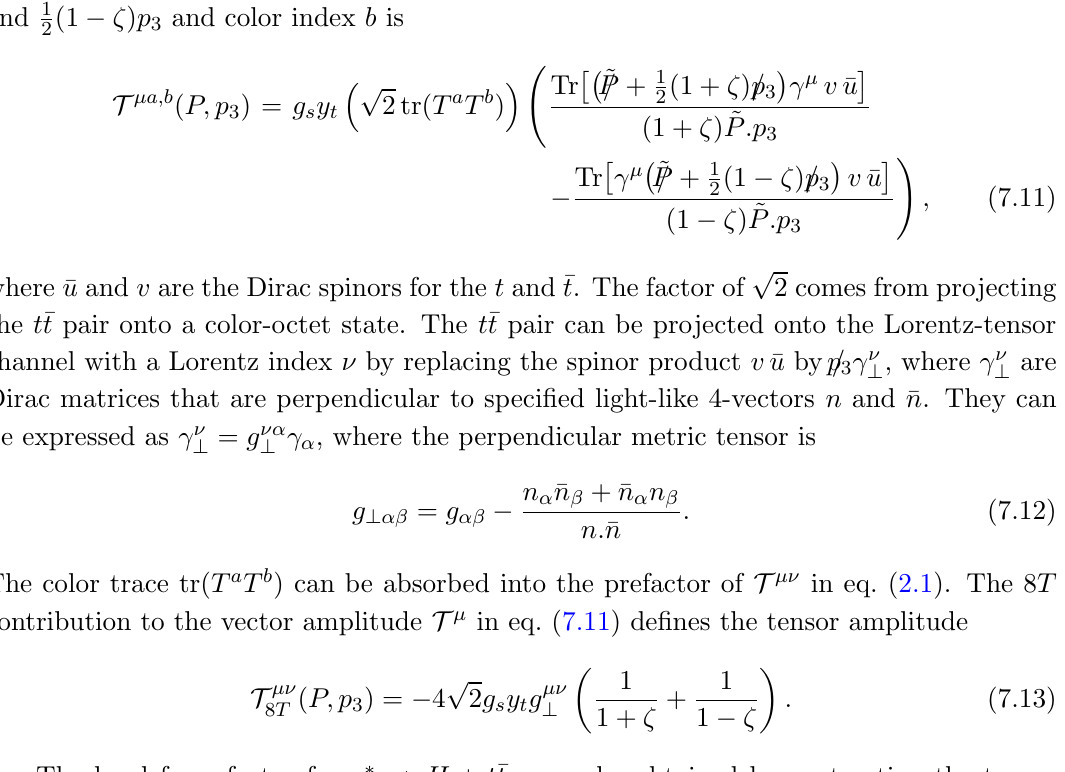
for producing a Higgs and H + t (cid:22) t 8 T